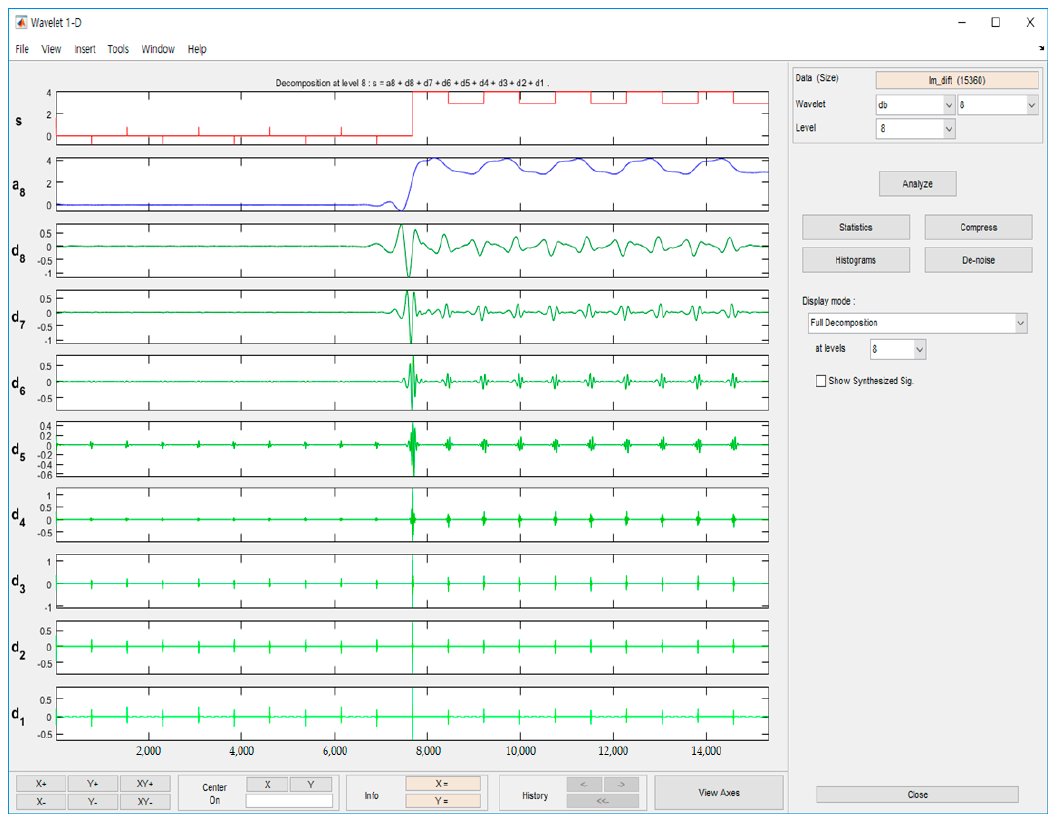
Figure 7. The analysis of discrete wavelet transform (DWT) of measured current at db8.